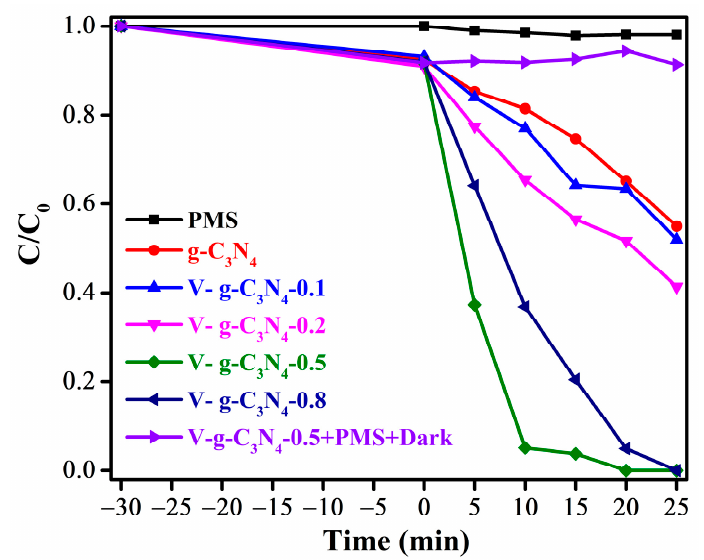
Figure 7. Removal efficiency of BPA by the prepared samples in the presence of PMS.